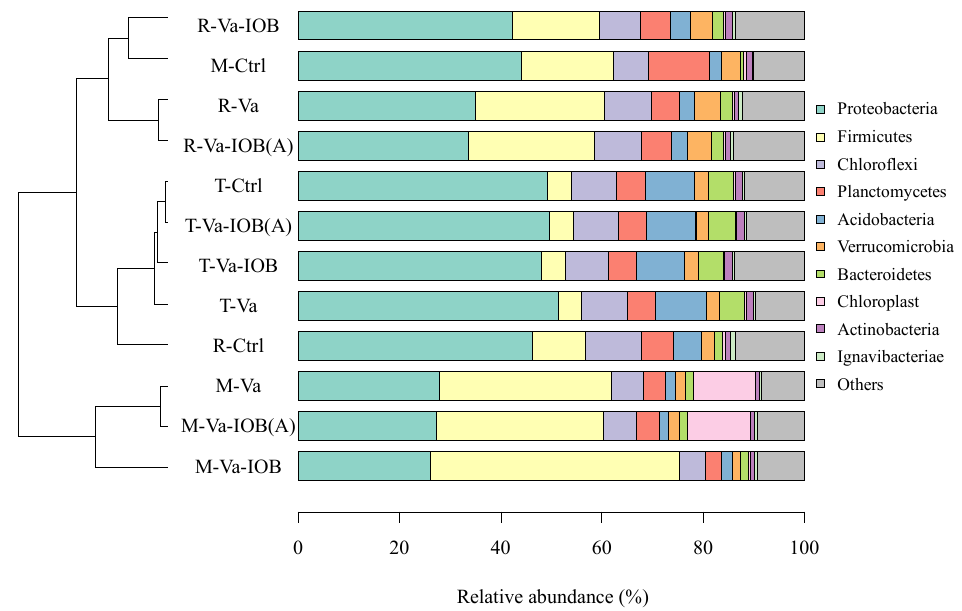
Figure 4. Clustering analysis of bacterial communities at the operational taxanomic unit (OTU) level (left) and bacterial community composition at the phylum level (right) in sediments under different treatments. T-, R-, and M- denote the transplanting, rapid growth, and mature stages of V. natans , respectively. Hierarchical clustering analysis was performed using unweighted pair group method with arithmetic mean (UPGMA) based on unweighted UniFrac distances from taxa tables and OTU number. The top 10 most abundant bacterial phyla are shown.